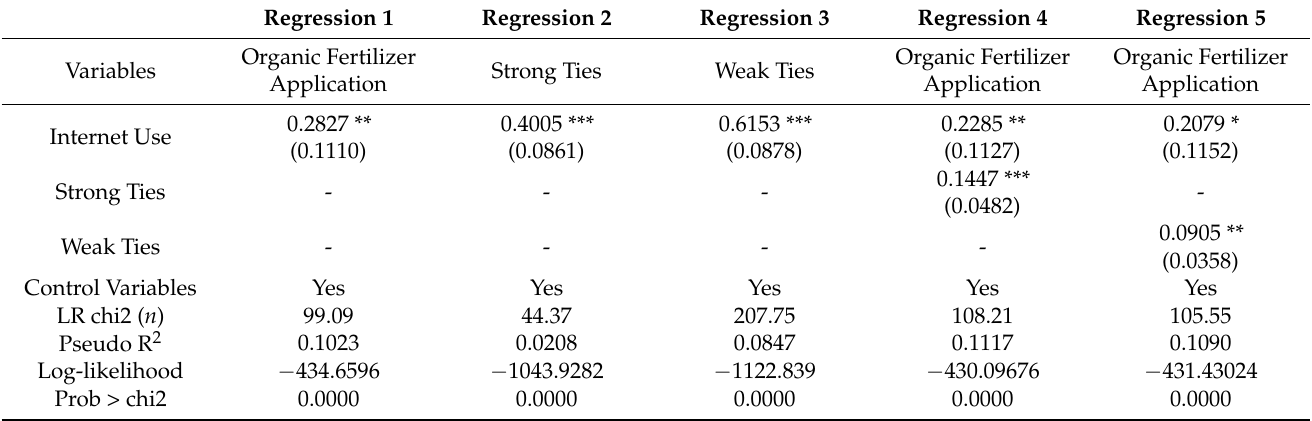
Table 6. Mediation role of social